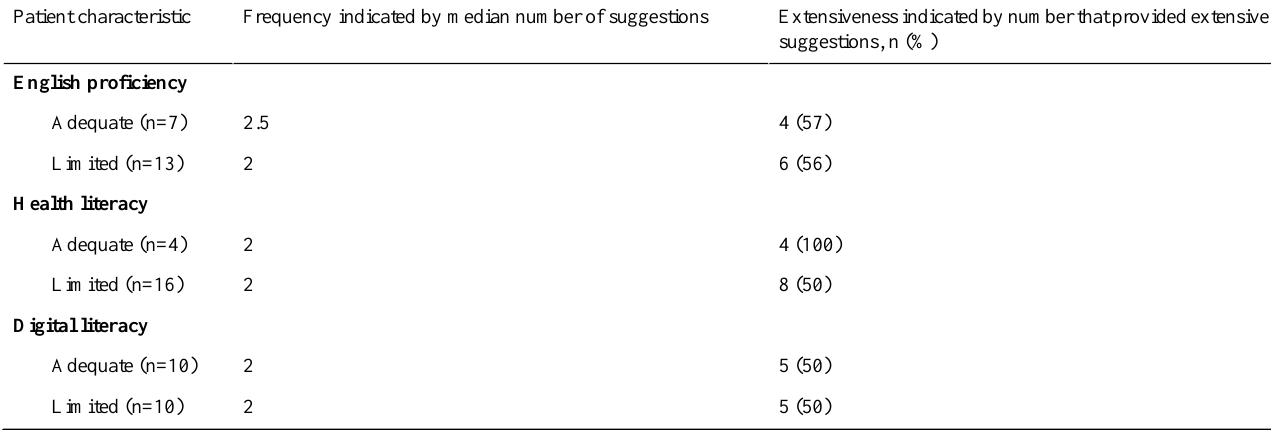
Table 4. Frequency and extensiveness of novel suggestions by English proficiency, health literacy, and digital literacy. (%)Frequency indicated by median number of suggestionsPatient